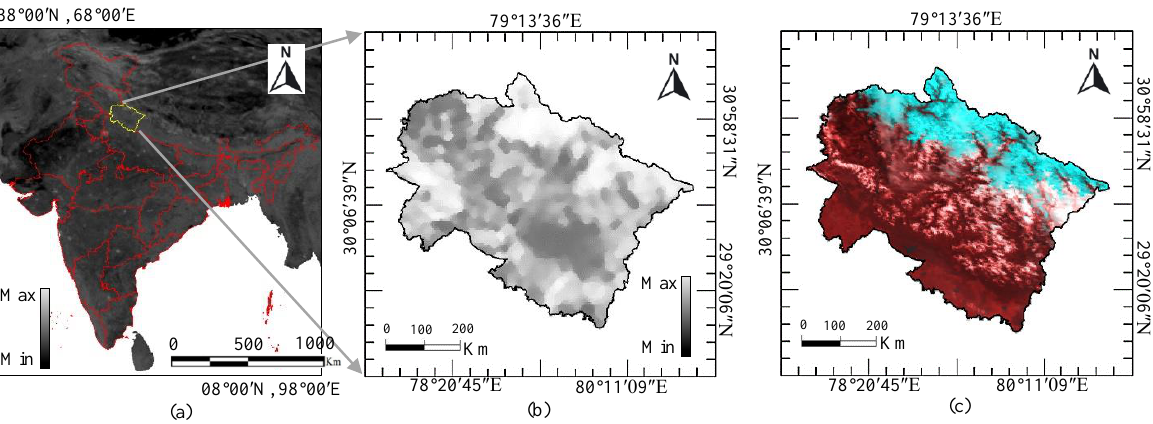
Fig. 1 Location of study site: (a) SCATSAT‒1 image of India (highlighted area representing nominated study area); (b) SCATSAT‒1 image (4‒May‒2020) of the study area (a part of Himalaya, India); (c) MODIS image (4‒May‒2020) of the study site.